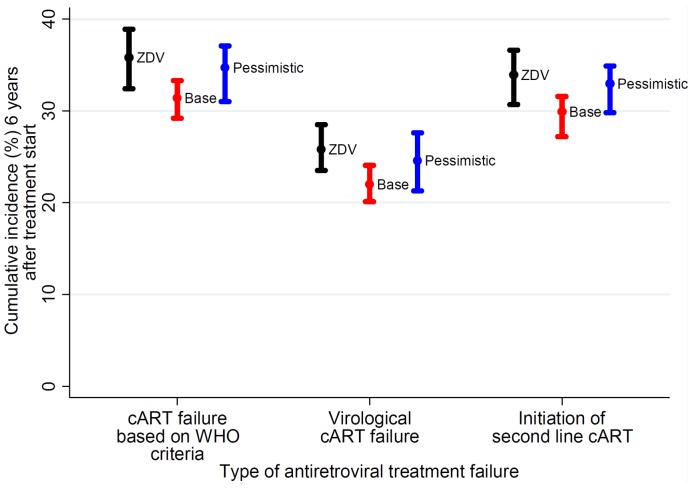
Shows different outcomes of first-line therapy by type of initial combination antiretroviral therapy (either including zidovudine [ZDV] or tenofovir [TDF]).For individuals starting with TDF, resistance emergence was modelled by two different scenarios (also see Figures 1B and 1C): a base scenario (red symbols) and a pessimistic scenario (blue symbols). Abbreviations: cART, combination antiretroviral therapy; WHO, World Health Organization.